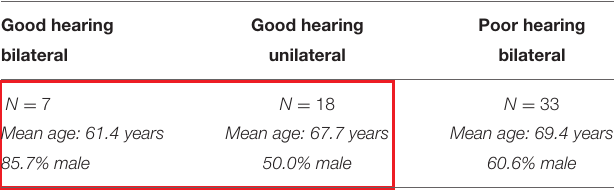
TABLE 3 | The demographics in the patients with audiometrically-confirmed bilateral ISSNHL, segmented by degree of hearing recovery post-ISSNHL. Bilateral ISSNHL: post-recovery hearing classification Good hearing Poor